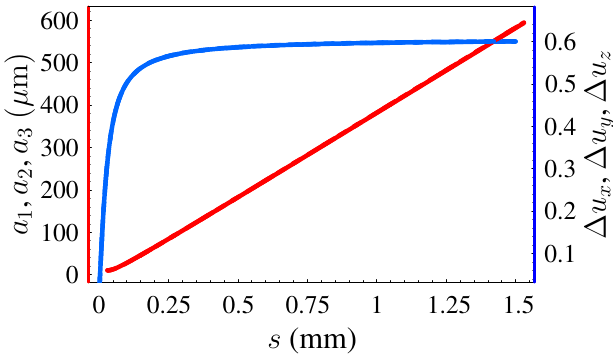
FIG. 3. (Color) Simulation of the space-charge blowup of an initially cold spherical electron distribution with parameters: Charge Q (cid:1) 1 nC , beam energy E 24 (cid:4) m , energy spread (cid:5) (cid:1) 0 , divergence x 0 distance between macroparticles n (cid:6) 1 = 3 (cid:1) 100 nm . Beam radius and RMS momentum spread radius r 0 along the three coordinate axes are shown as a function of propagation distance s